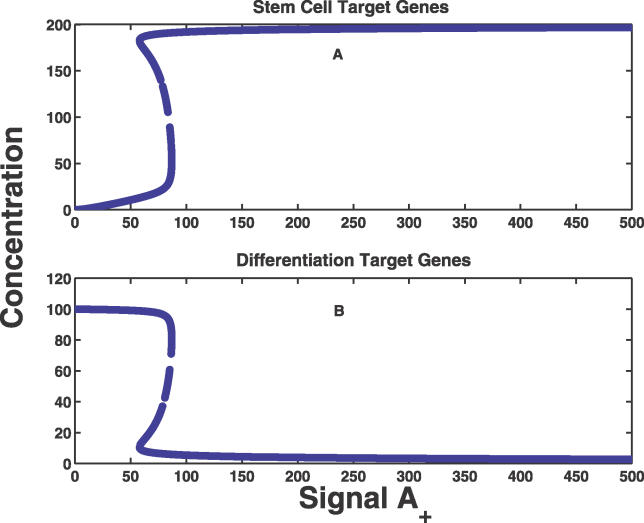
Steady State Values of the TG Expression as a Function of the Input Concentration A
+ for Stem Cell and Differentiation Genes, Respectively, for Case II(A) Stem cell genes.(B) Differentiation genes.